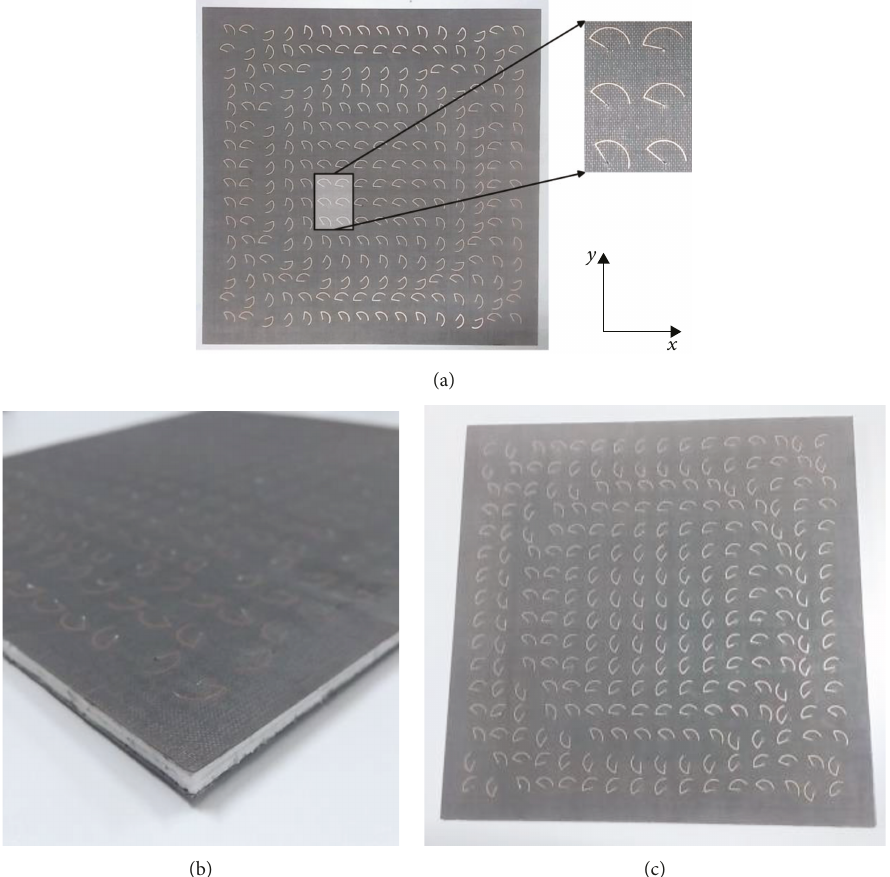
Figure 8: Photographs of the dual-band CP re fl ectarray: (a) top view, (b) side view, and (c) bottom view.